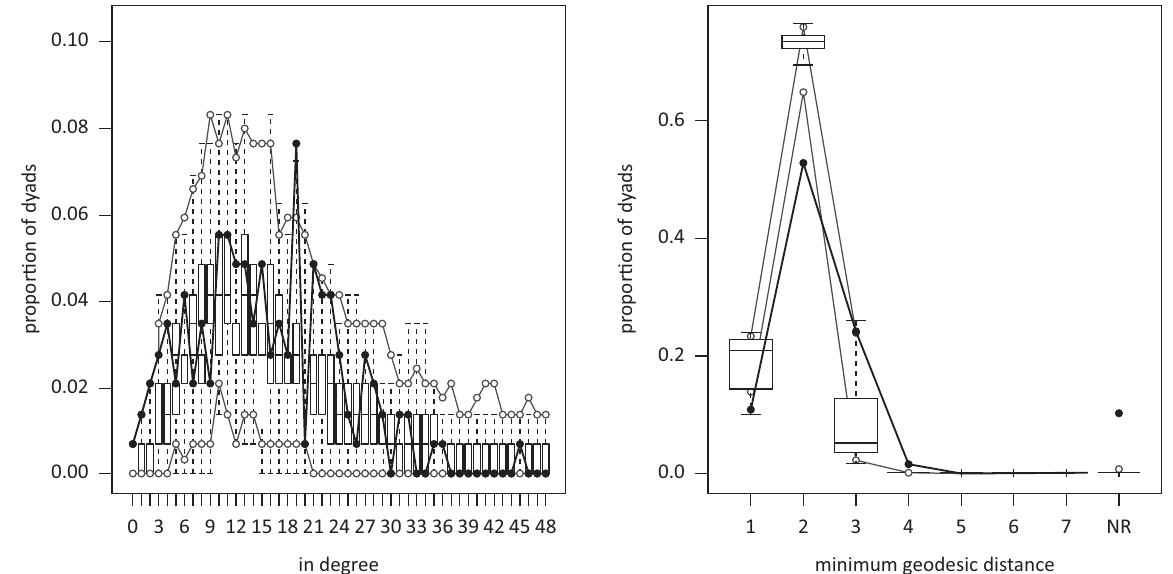
Figure 2. Goodness‐of‐fit diagnostics (Model 4: Dutch MPs Twitter mentions